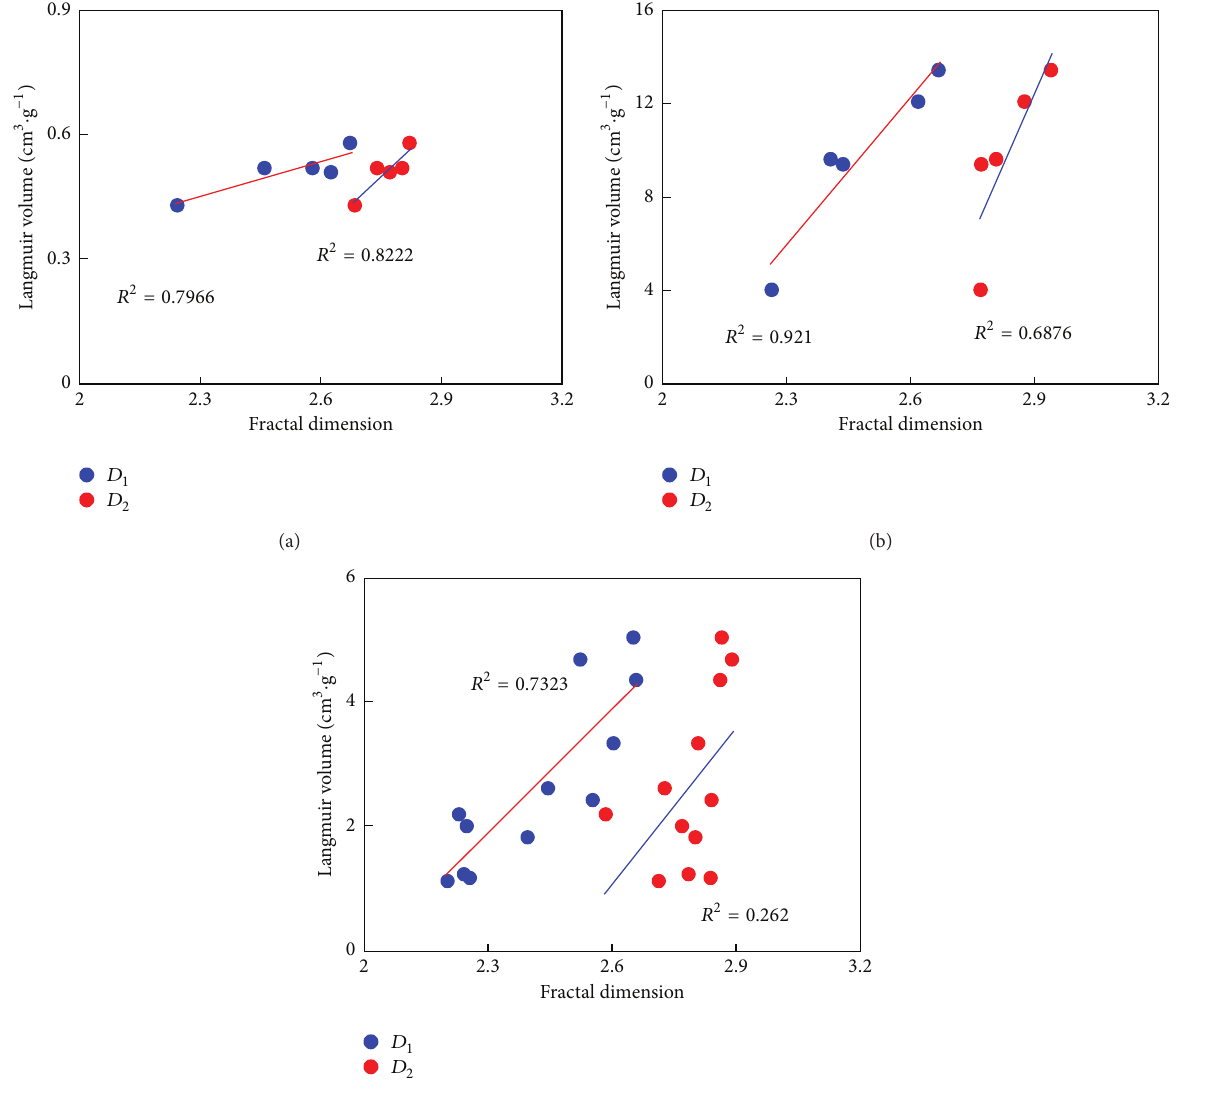
Figure 6: Relationships between fractal dimension and Langmuir volume (data in (a) from [1]; data in (b) from [7]; data in (c) from